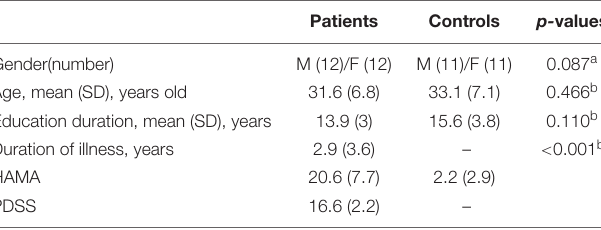
TABLE 1 | Demographic data of patients with panic and healthy controls.